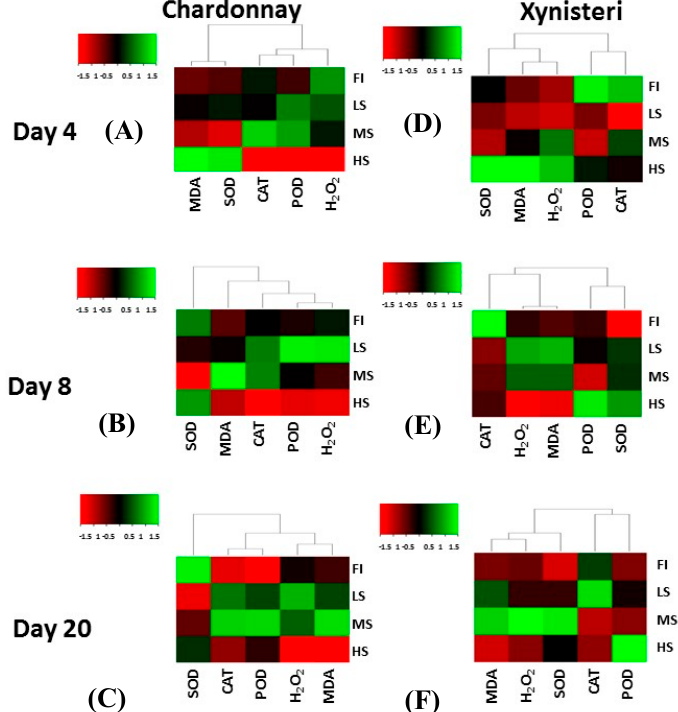
Figure 6. Relative changes in damage index (malondialdehyde (MDA), H 2 O 2 ) and antioxidative enzymes (superoxide dismutase (SOD), catalase (CAT), peroxidase (POD)) after exposure of grapevine cultivars, Chardonnay ( A,B,C ) and Xynisteri ( D,E,F ), to water and heat stress. Heat map representing relative composition level of molecules traits after 4, 8 and 20 d of light water stress (LS) with 80% of the FI, moderate water stress (MS) with 50% of the FI, and heat stress (HS) as compared to control (full irrigation, FI) plants. Red shades indicate the lower level (less than − 1.5 fold), deep red corresponds to − 1 fold, black signifies that the level is not different from the control, deep green corresponds to 1 fold, clear green indicates that the level is more than 1.5-fold higher than the control. MDA and H 2 O 2 are expressed in μ mol/g; SOD, CAT and POD in units/mg protein.